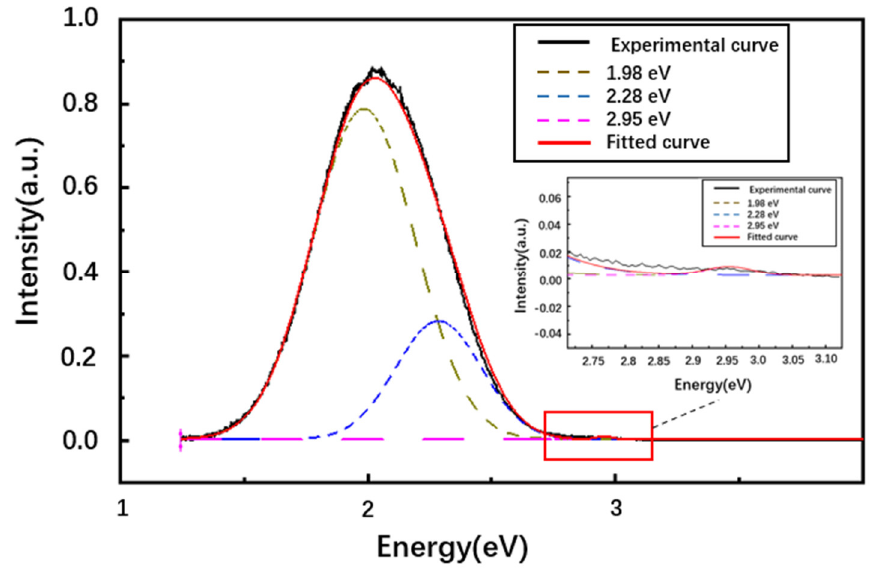
Figure 7. A typical Gaussian decomposition of the IBIL spectrum of the annealed 4H-SiC sample at a fluence of 1.45 × 10 11 ions/cm 2 .